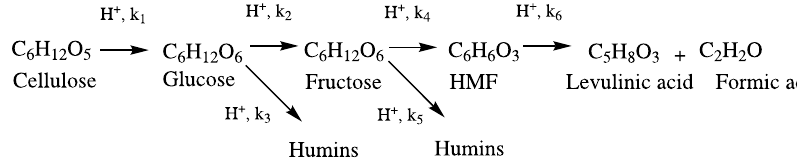
Figure 1. Reaction mechanism for the kinetic study in the conversion of cellulose to HMF.